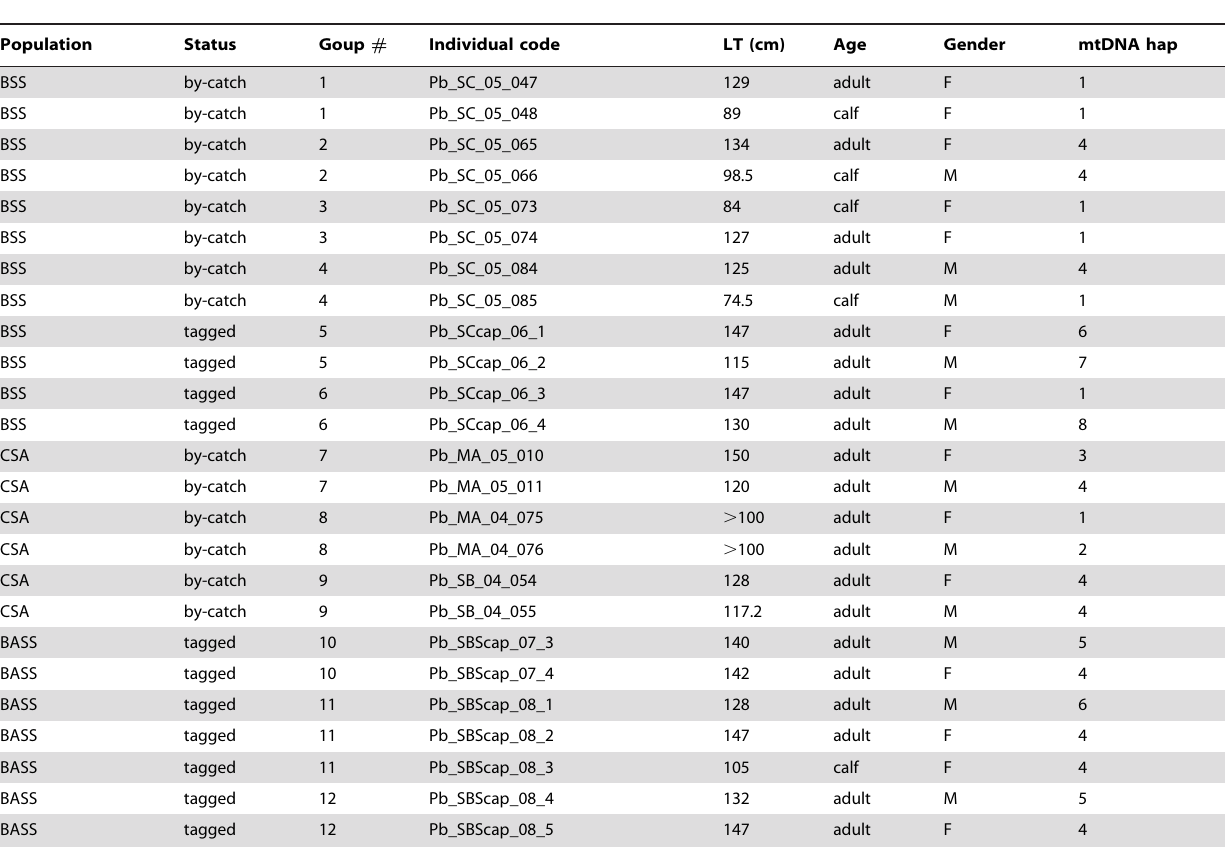
Table 1. Demographic and genetic information of the captured and released groups and simultaneously entangled